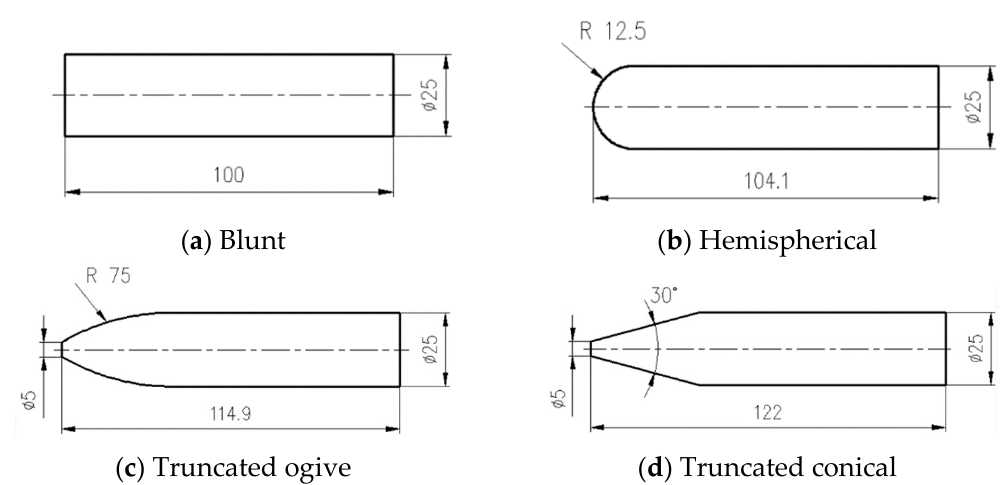
Figure 1. Structure diagrams of test projectiles (all values in mm).